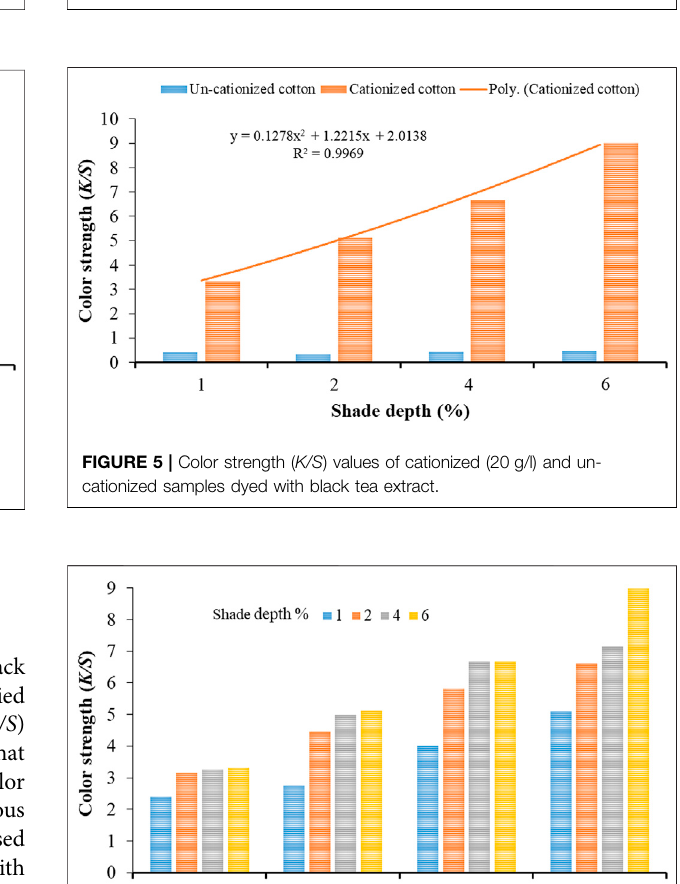
FIGURE 2 | Color strength ( K/S ) values of cationized (5 g/l) and un- cationized samples dyed with black tea extract.